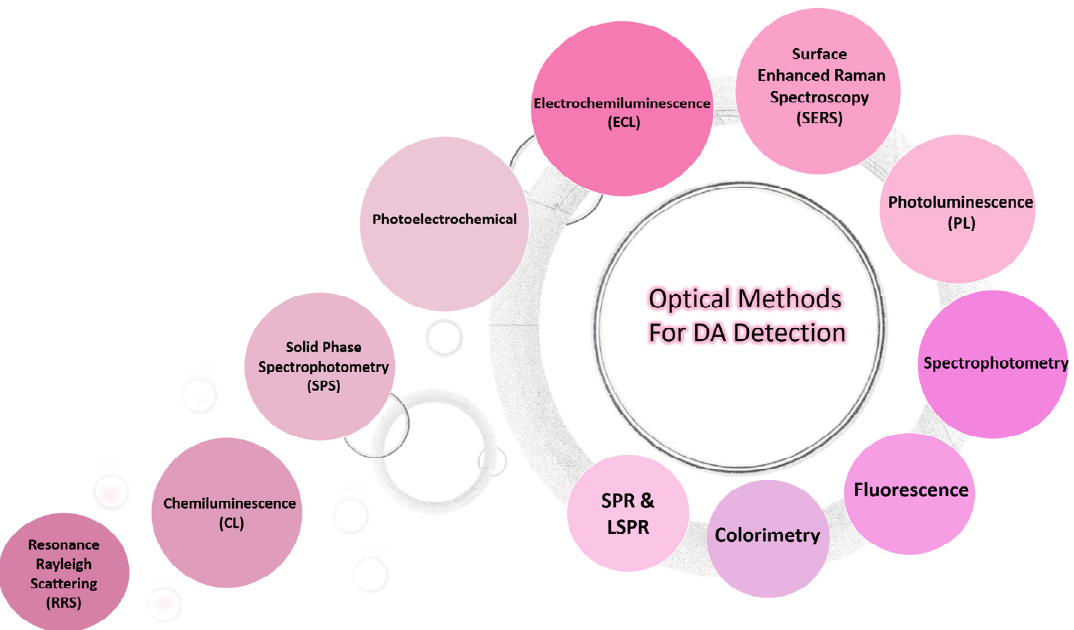
Figure 2. Di ff erent optical methods used to detect Figure 2. Different optical methods used to detect DA.